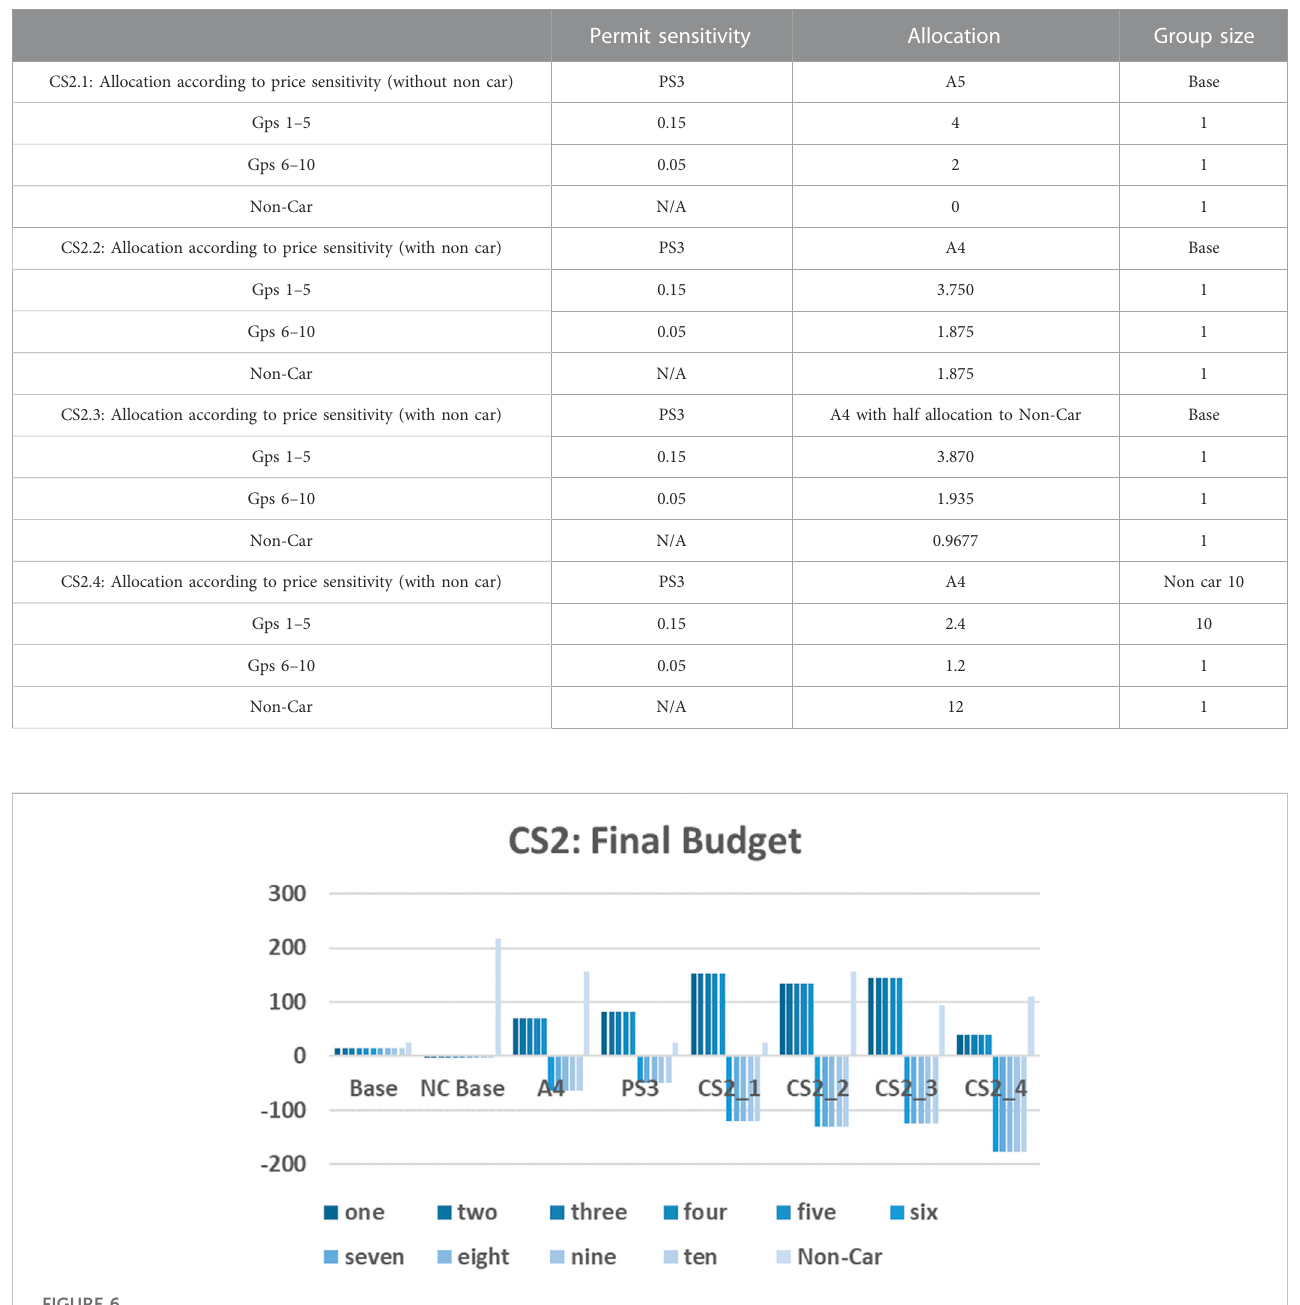
TABLE 6 CS2 scenarios.